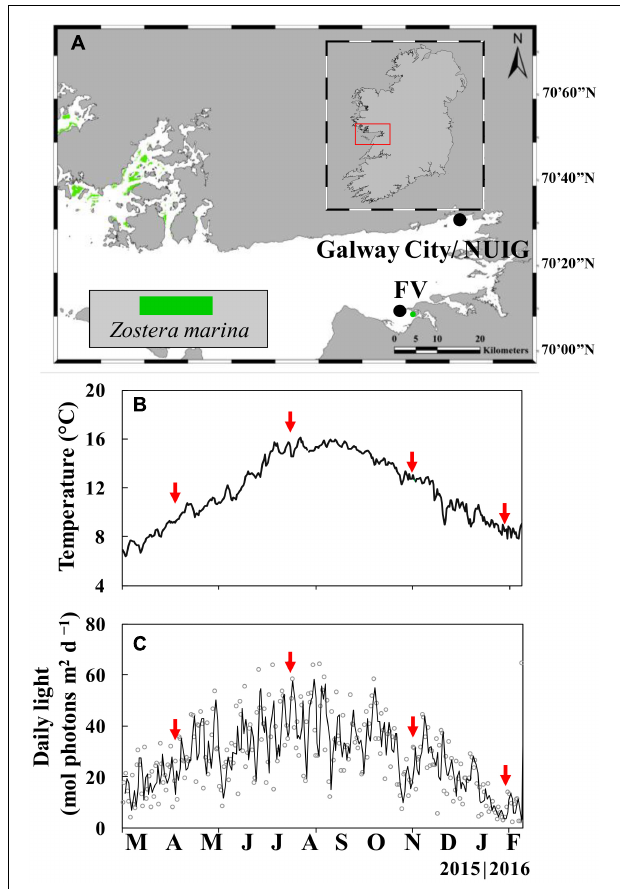
FIGURE 1 | Map of Galway Bay (red rectangle) in western Ireland with Zostera marina meadows (green color; from Beca-Carretero et al., 2020) and the studied population at Finavarra (FV) (A) . Data of daily sea surface temperature (SST) (B) , and measurements of daily irradiance (mol photons m − 2 d − 1 ) measured on the roof of the Martin Ryan Building, NUI Galway, Galway City (C) . Red arrows represent the date of sample collection in April (spring), July (summer), November (autumn) (all 2015) and January